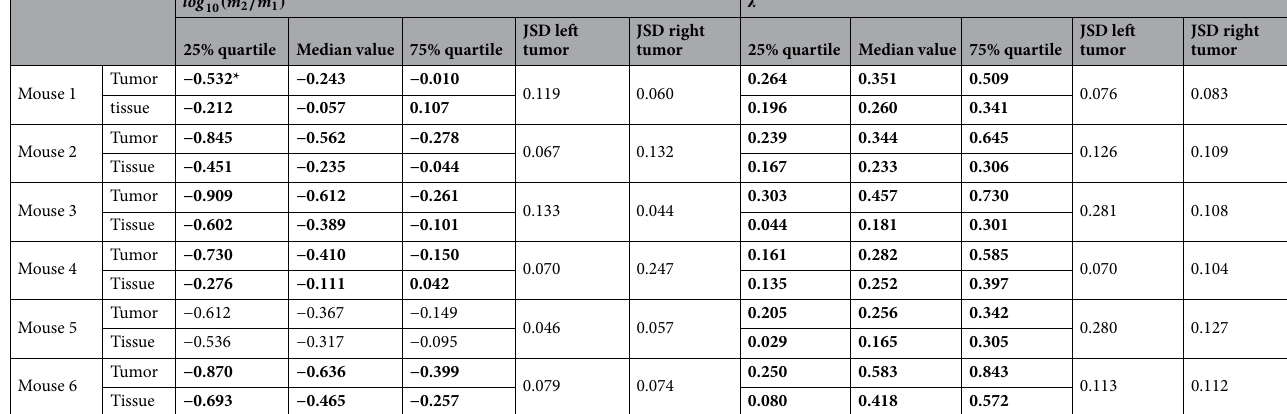
Table 2. Median value, two quartiles, and JSD of parameter values for each mouse. *The bolded description represents that there is a one−quartile difference in parameter values between tumor and